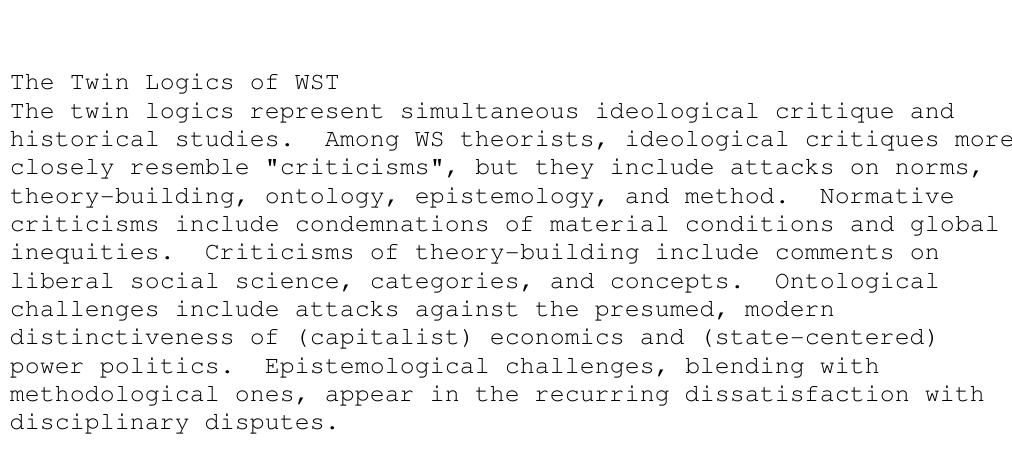
Figure 2. The Twin Logics of